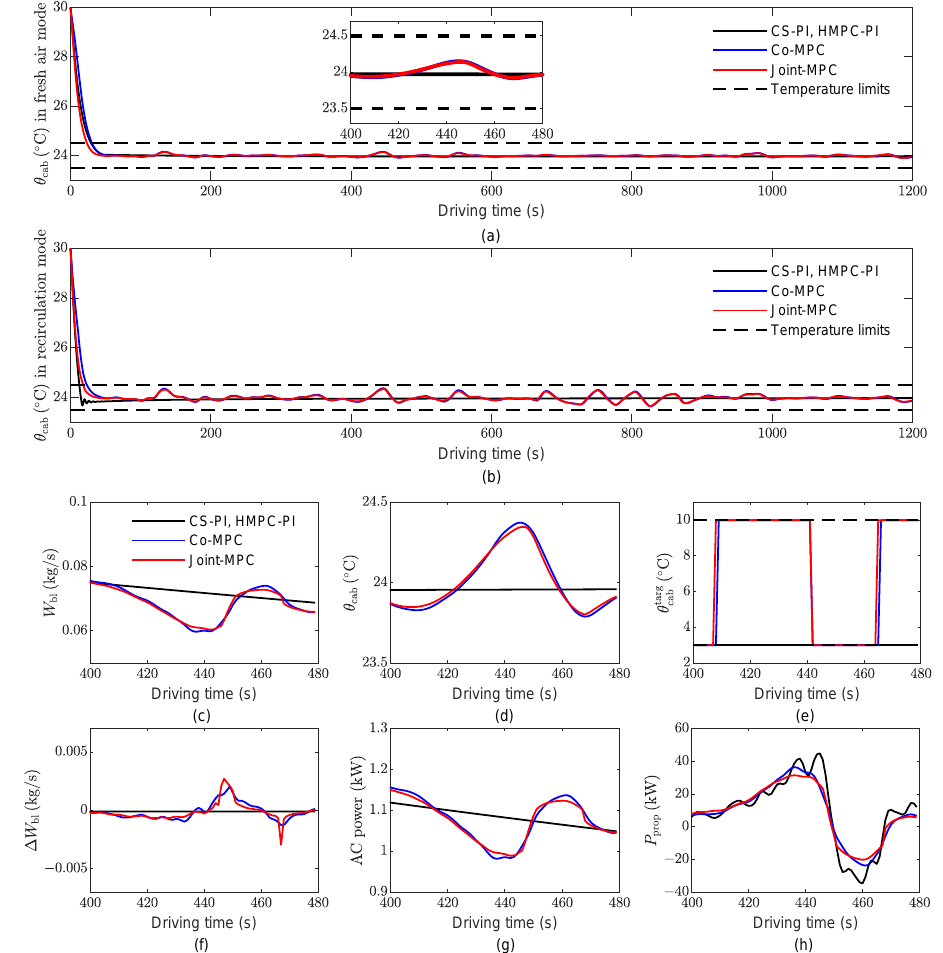
Figure 8. Thermal results of the first case study, as well as a comparison of the different methods during a short period. ( a ) Cabin air temperature trajectory in fresh-air mode; ( b ) Cabin air temper- ature trajectory in recirculation mode. The comparison includes the ( c ) Blower rate; ( d ) Cabin air temperature; ( e ) Evaporator wall temperature target; ( f ) Increment of the blower rate; ( g ) AC power; ( h ) Propulsion